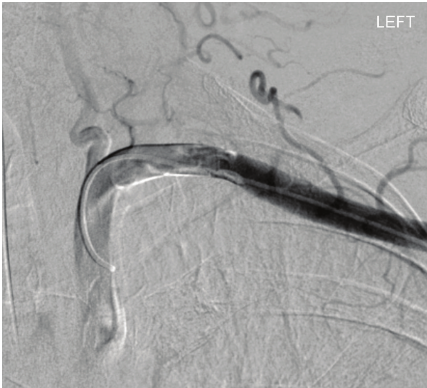
Figure 7: Catheter angiogram following deployment of Angio-Seal